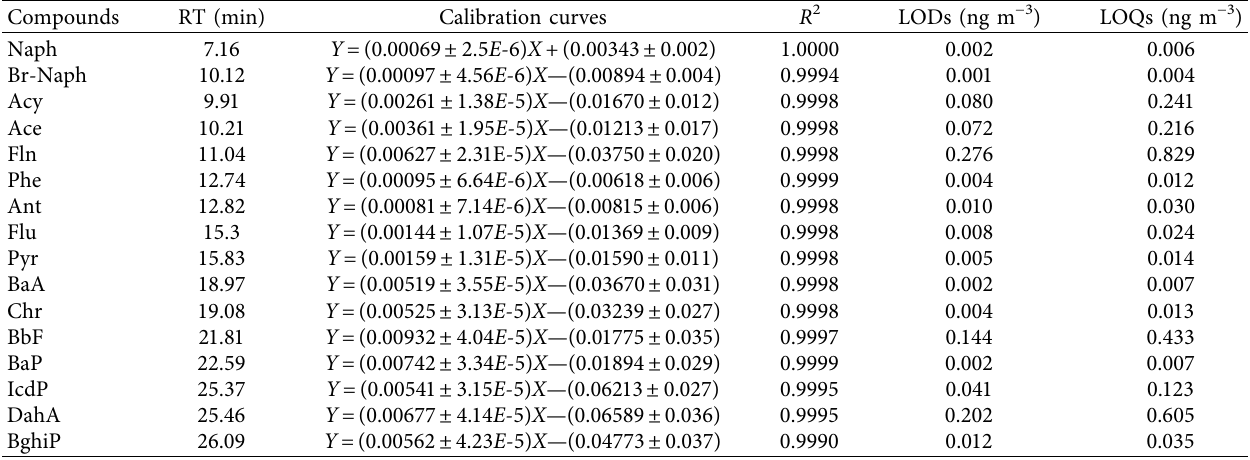
Table 2: Analytical figure of merits of PAHs on the GC-EI-MS/MS. Compounds